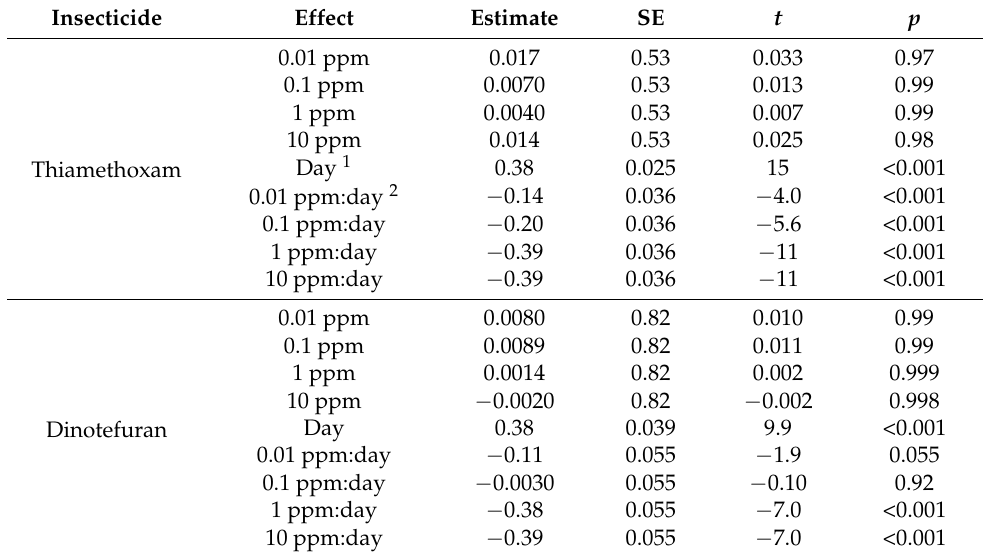
Table A2. Parameter estimates for GLMMs to explain the growth rate of Aromia bungii